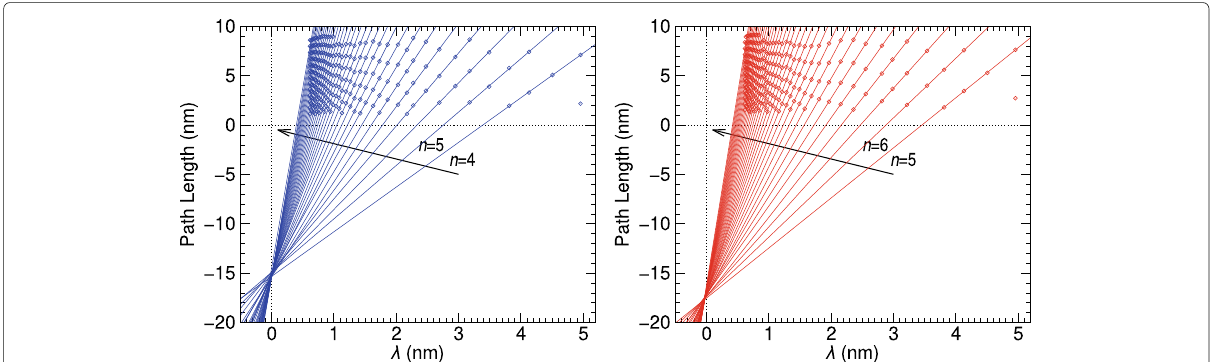
Fig. 12 Path length at the optimal gaps as a function of λ . The path length of PS1 (left) and PS6 (right) in LH and LV mode, respectively, are shown. Calculated values from the optimal gaps are shown in circles. Solid lines are the results of linear fitting